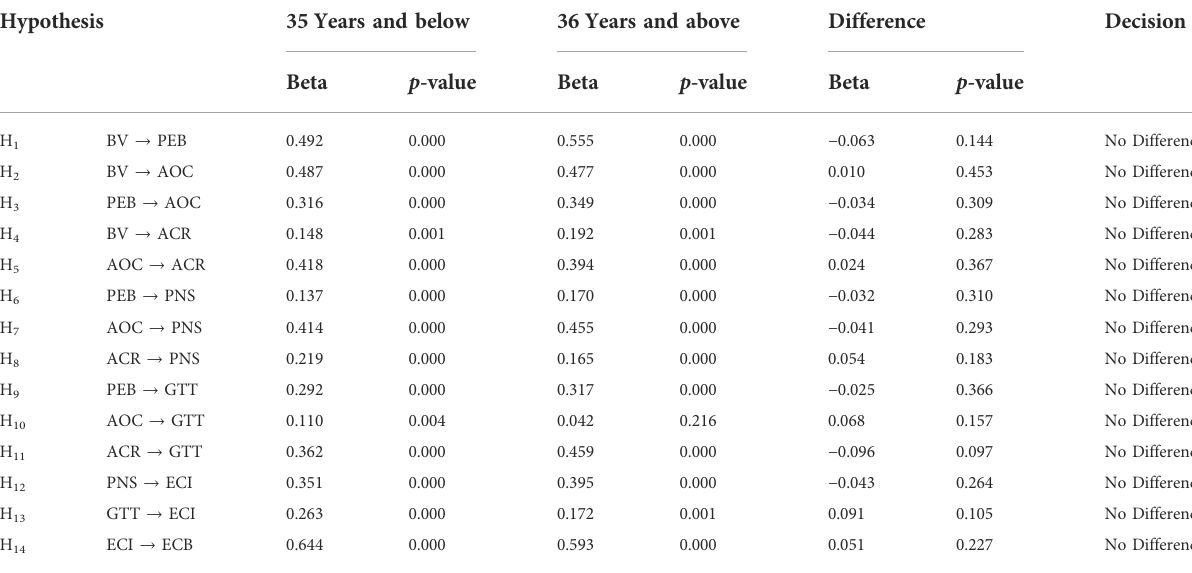
TABLE 7 Multi-group analysis — age.